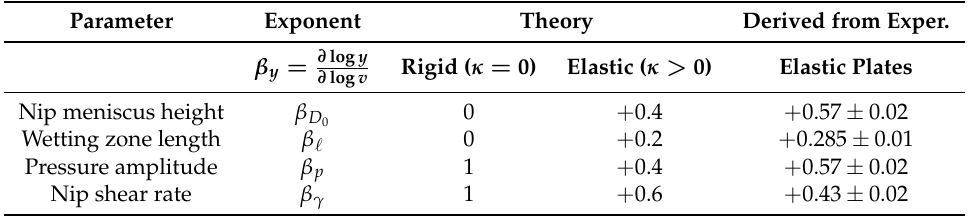
Table 5. Estimates of scaling exponents of further parameter as a function of the printing velocity v , derived from the exponents in Table 4: meniscus height D 0 , length of the wetting zone (cid:96) , pressure amplitude p 0 , and shear rate ˙ γ